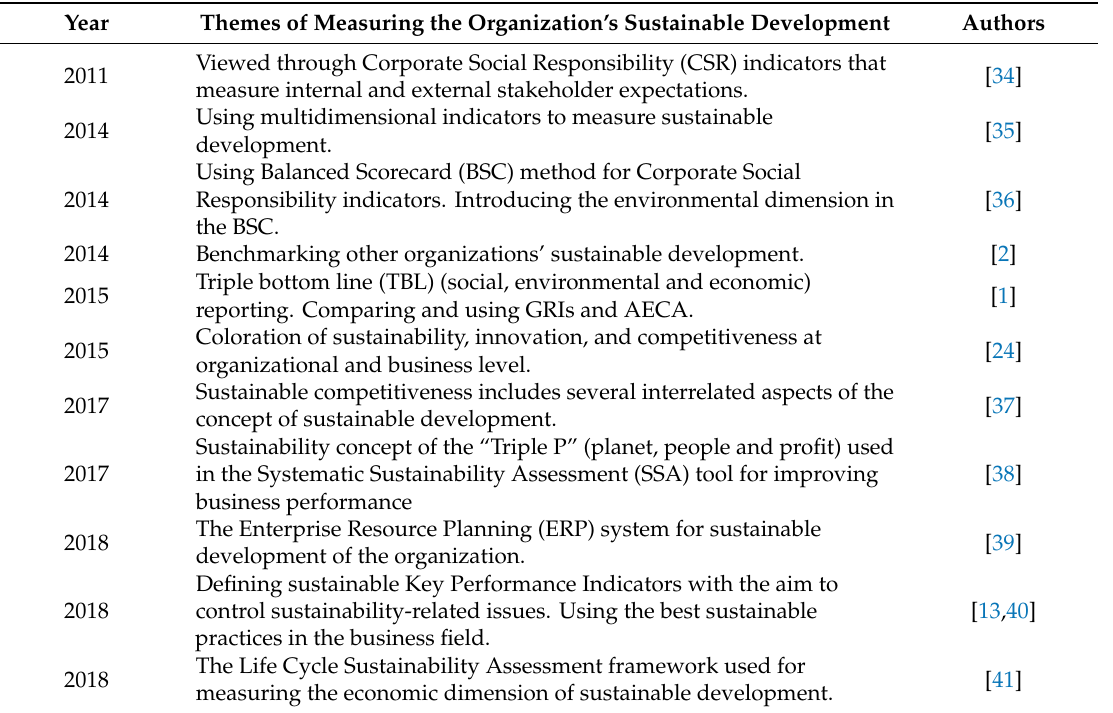
Table 2. The themes related to organizational performance and sustainable